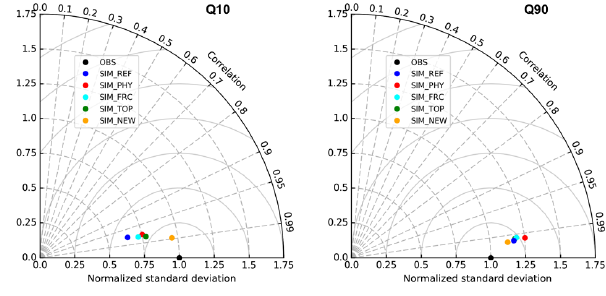
Figure 6. Maps of the difference in mean NSE for NSE>0 be- tween the following simulations: (a) SIM_PHY and SIM_REF, (b) SIM_FRC and SIM-PHY, (c) SIM_TOP and SIM_FRC, (d) SIM_NEW and SIM_TOP.